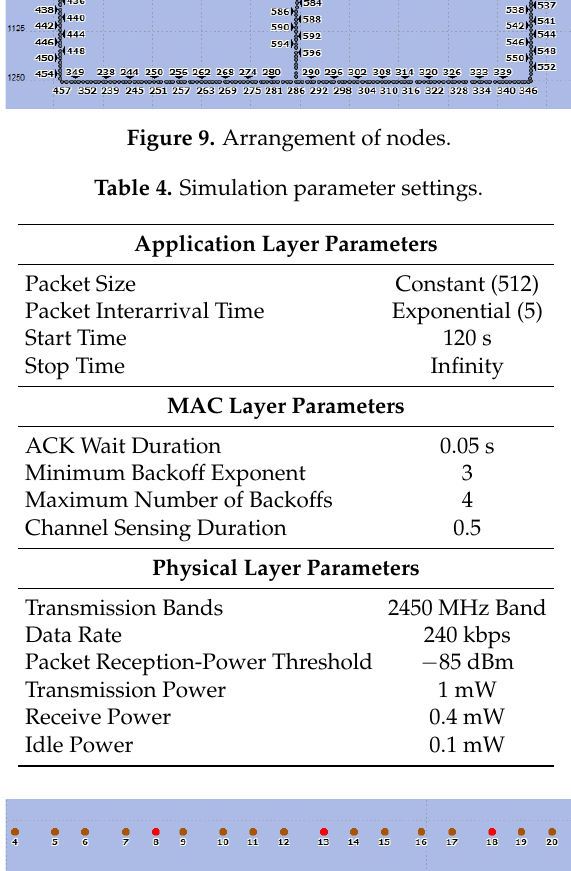
Figure 10. Arrangement of wireless sensor nodes in the vicinity of a leakage